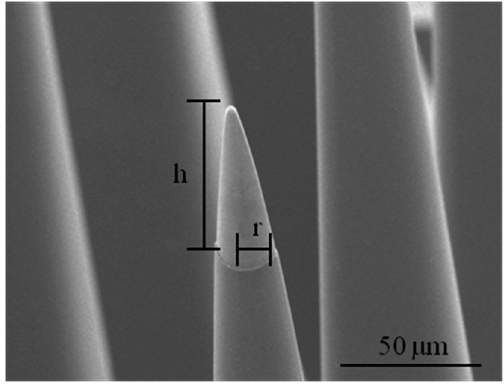
Figure 12. Electrode tip dimensions; the height ( h ) and radius ( r ) of the tip.